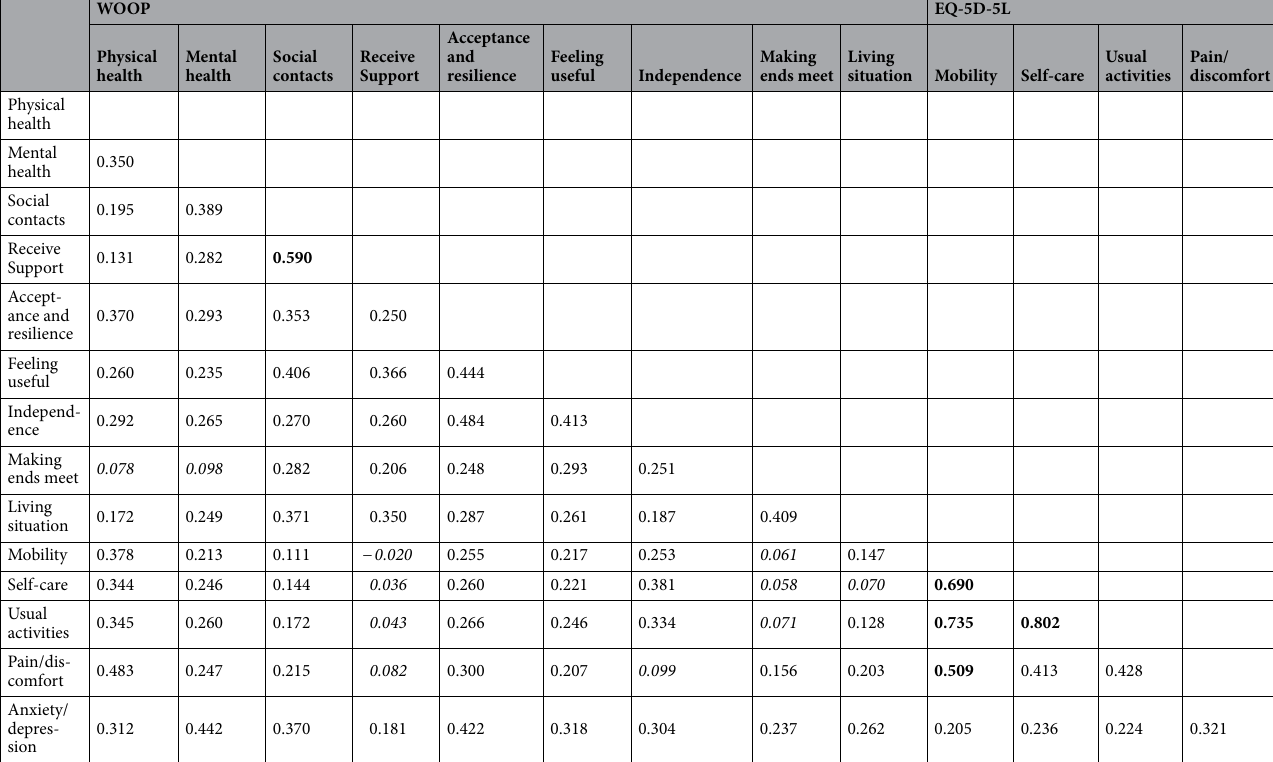
Table 2. Spearman correlations between WOOP and EQ-5D-5L items, n = 322. *Bold suggests high correlation, italics suggests trivial correlation.